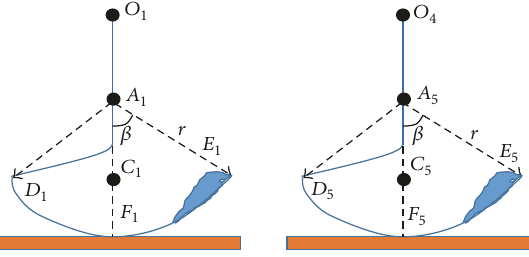
Figure 4: Self-balanced position of elastic